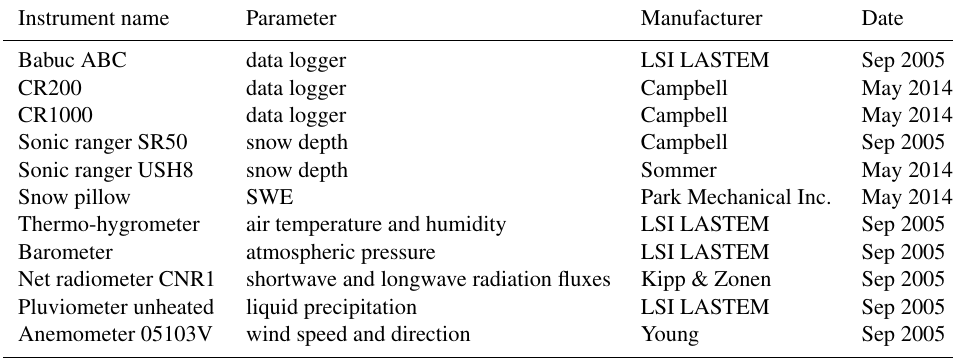
Table 1. Instrumentation at the Forni Glacier with instrument name, measured parameter, manufacturer, and starting date. Instrument name Parameter